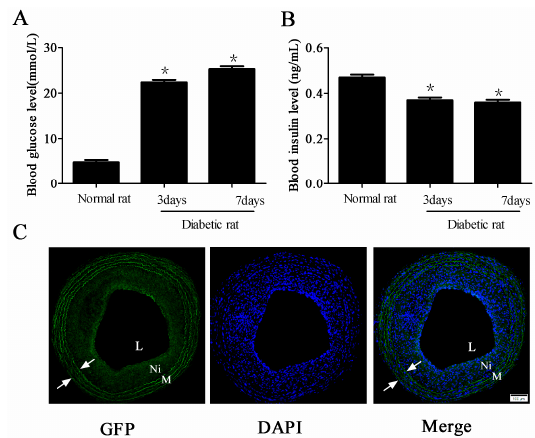
Figure 1. Adenovirus transfection into the carotid artery in diabetic rats successfully at two weeks after balloon injury. ( A , B ) The changes of fasting blood glucose ( A ) and plasma insulin ( B ) levels after injection of streptozotocin (STZ) ( n = 10 in normal rat group, n = 50 in diabetic rat group, * p < 0.05 vs. normal rat group); and ( C ) Representative microphotographs of fluorescent microscopy after adenovirus transfection (100× magnification). Green fluorescent protein (GFP) and nuclei with 4 ′ ,6-diamidino-2-phenylindole (DAPI) were labelled with green and blue fluorescence, respectively. Arrows indicate the elastic lamina; L: Lumen; M: Media; Ni: Neointima. Scale bar represents 100 μ m.